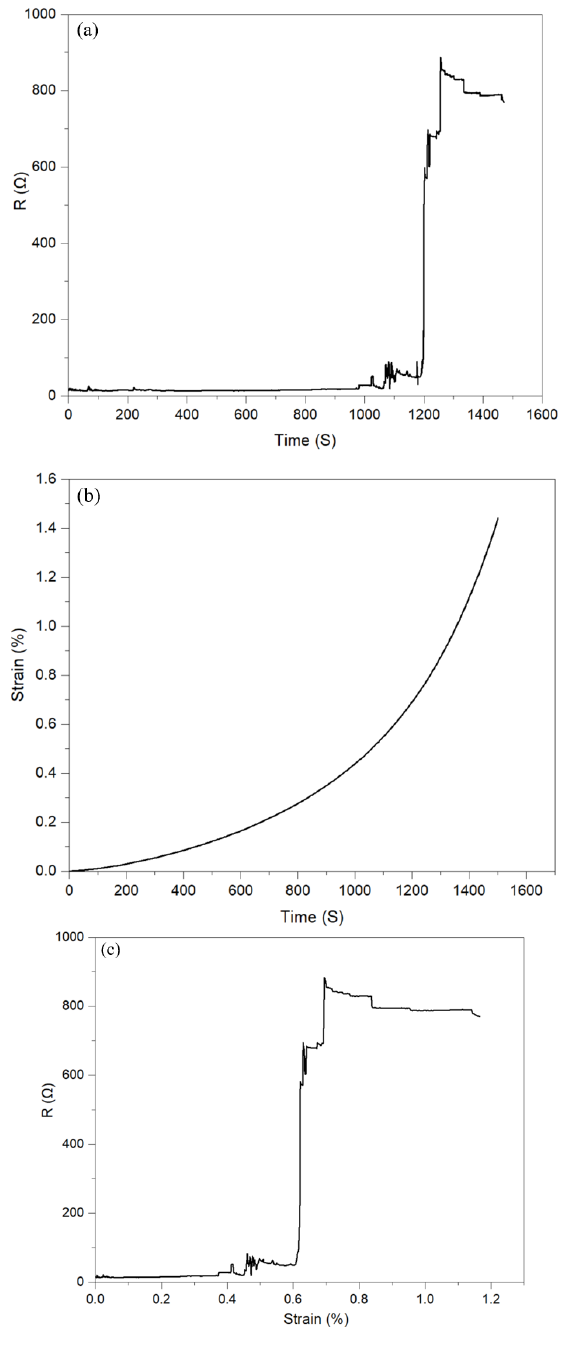
Figure 6. ( a ) Resistance over time upon the applied strain, ( b ) strain curve over time upon the applied force from 0–5 N, and ( c ) resistance over the applied strain (1.5 % reading accuracy for